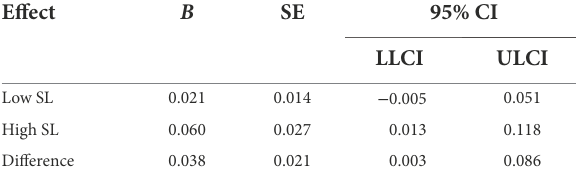
TABLE 4 The moderated mediating effect testing